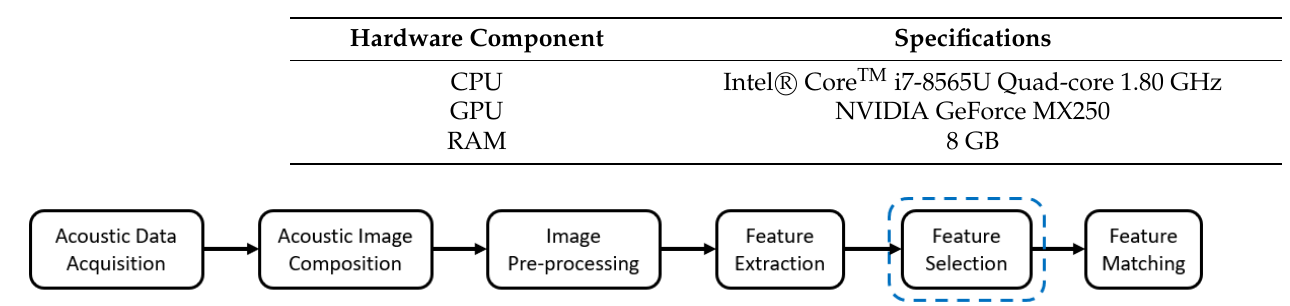
Table 3. Hardware specifications of the testing device.